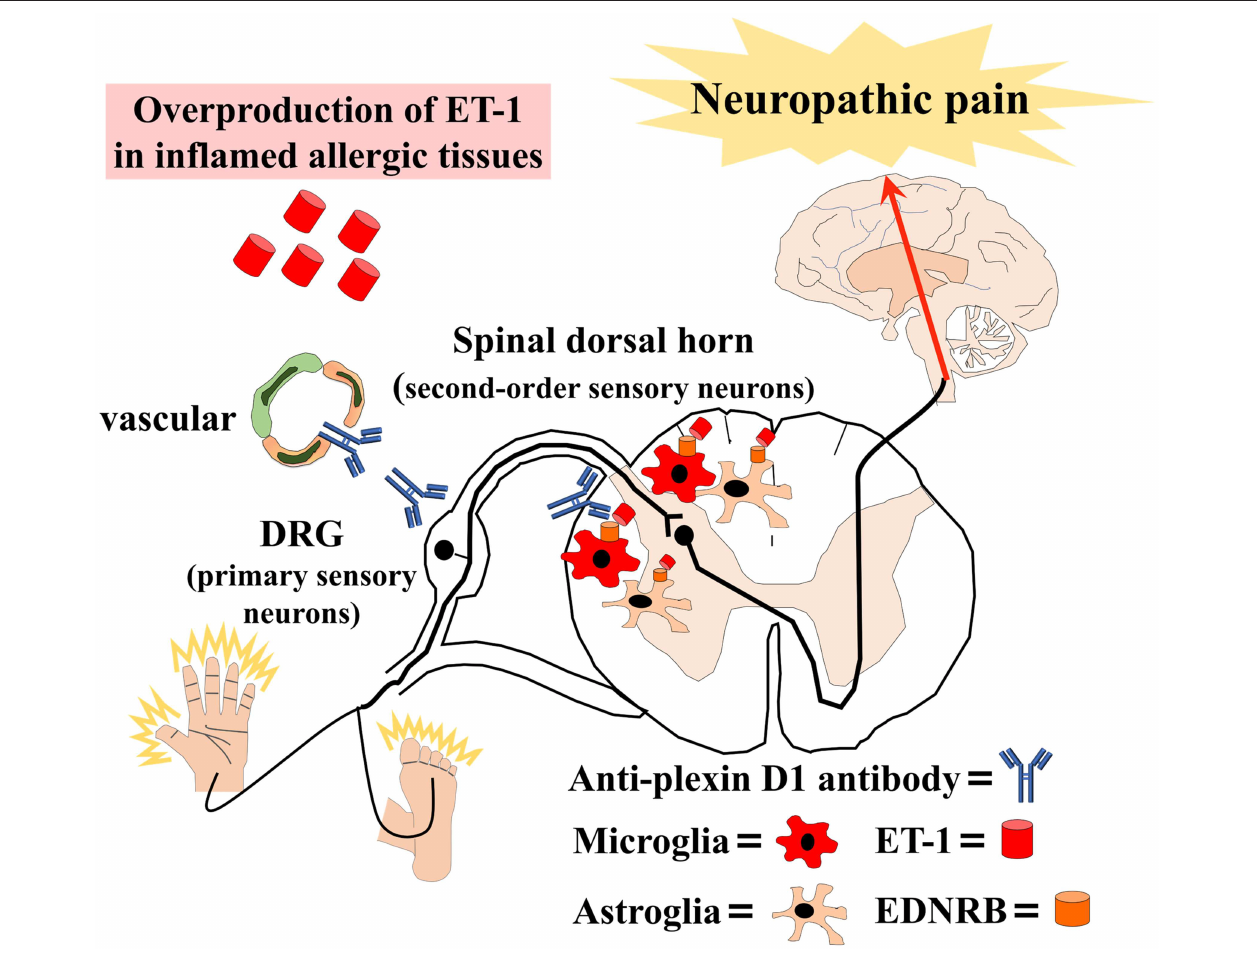
FIGURE 1 | Schematic overview of our hypothesis that allergic inflammation induces immune-mediated neuropathic pain. Anti-plexin D1 antibodies invade the dorsal root ganglia (DRG) where the blood–brain barrier (BBB) and blood–nerve barrier are absent, bind to unmyelinated small DRG neurons (primary sensory neurons), and cause neuropathic pain. Moreover, the overproduction of ET-1 (endothelin-1) in inflamed tissues induces BBB hyperpermeability and activates microglia and astroglia via the ET-1/EDNRB (endothelin receptor type B) pathway in allergic inflammation. Glial activation leads to the activation of second-order sensory neurons in the dorsal horn of the spinal cord and, ultimately, neuropathic